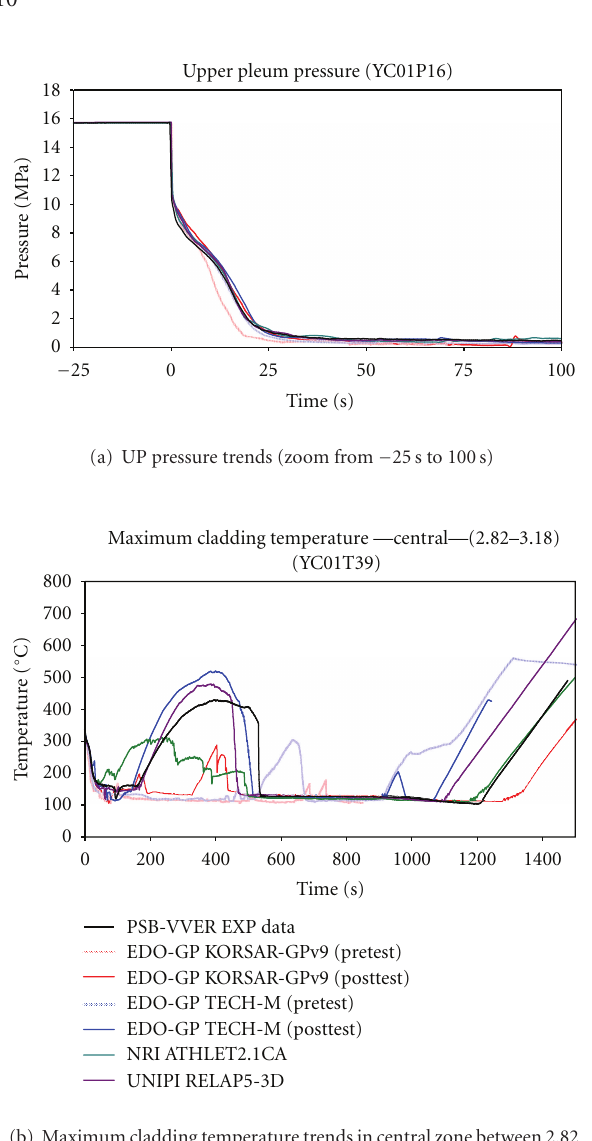
Figure 5: Qualitative evaluation of the results: experimental versus calculated time